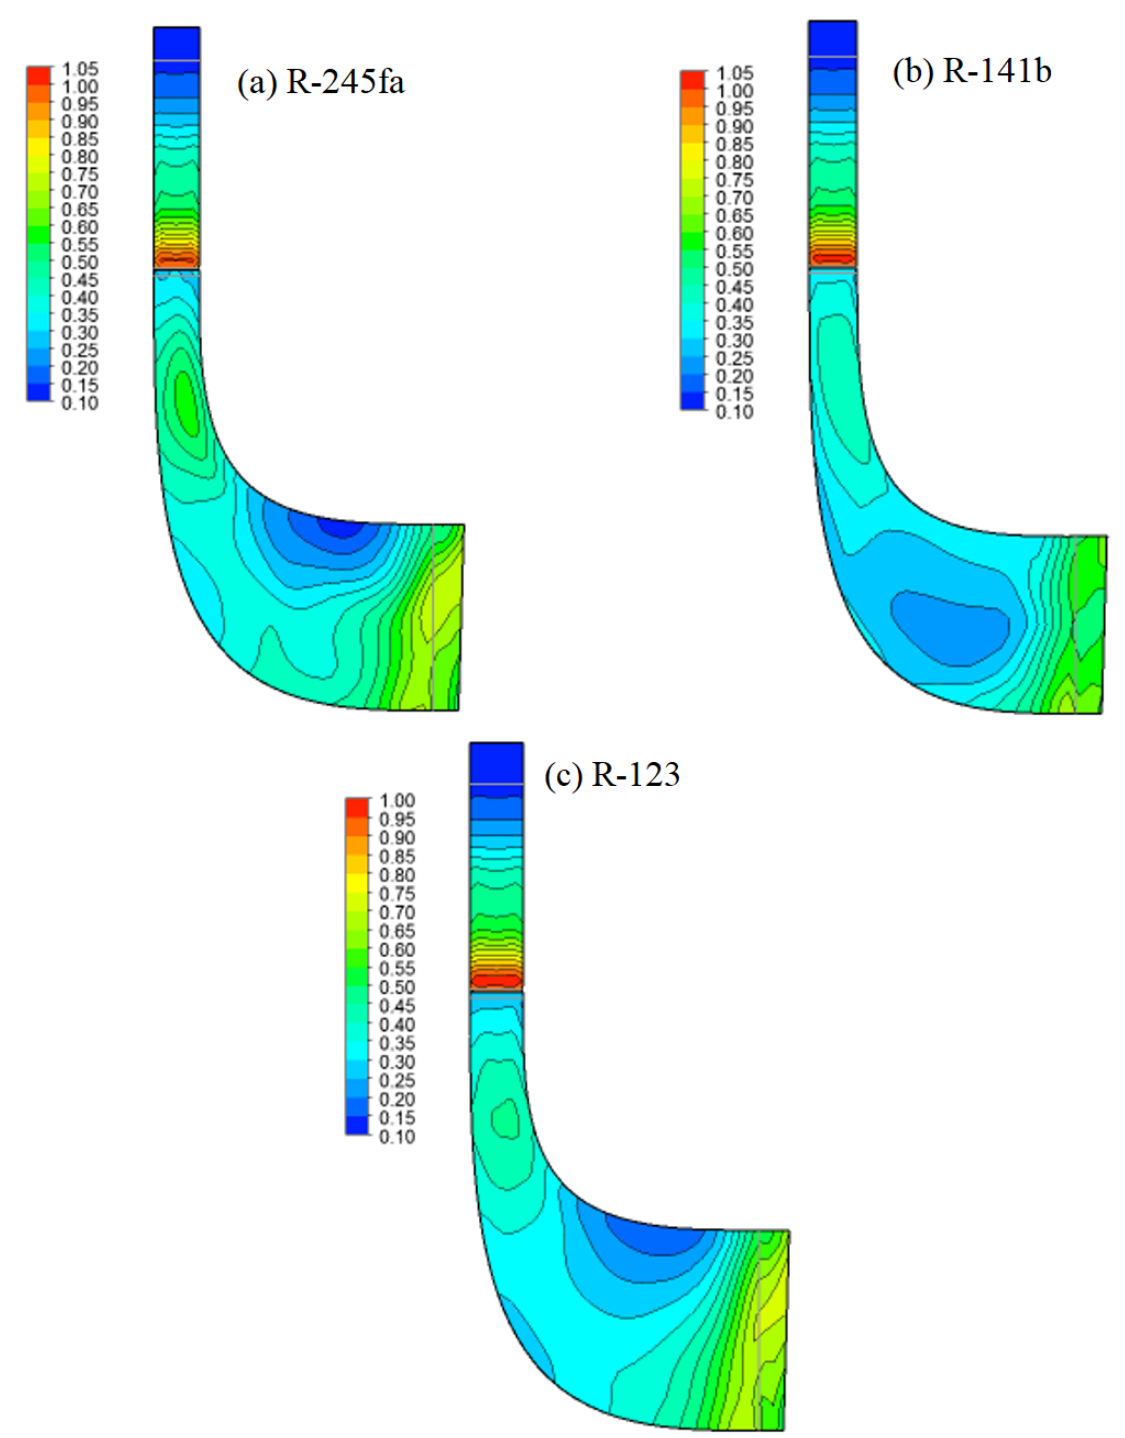
Figure 11. Distribution of the Mach number in the meridional plane of the nozzle-rotor set. Following the radial turbine nozzle and rotor results under design conditions, the next stage of this work consisted of analyzing the behavior of this component under off-design conditions. The main results from this analysis are presented